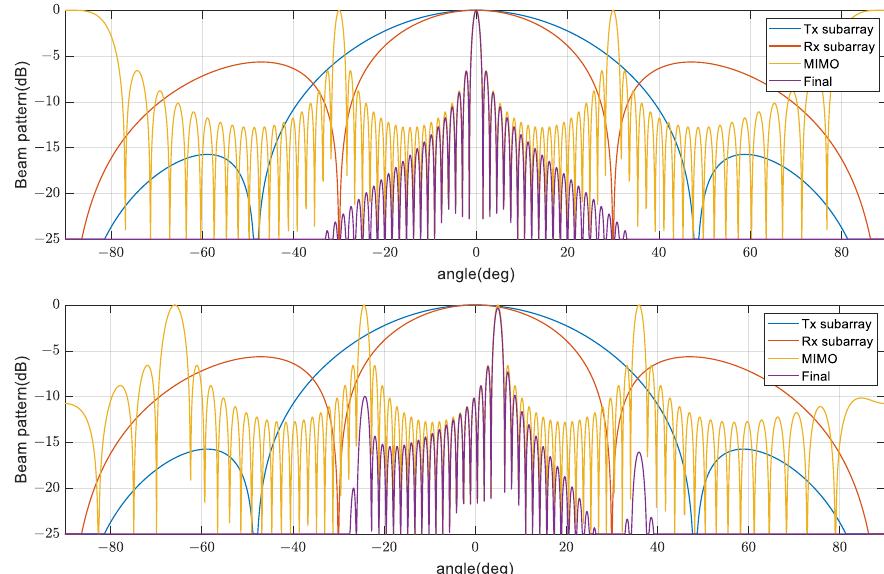
Figure 14. Final beampatterns by minimum redundant MIMO steered to 0° ( up ) and 5° ( down ).